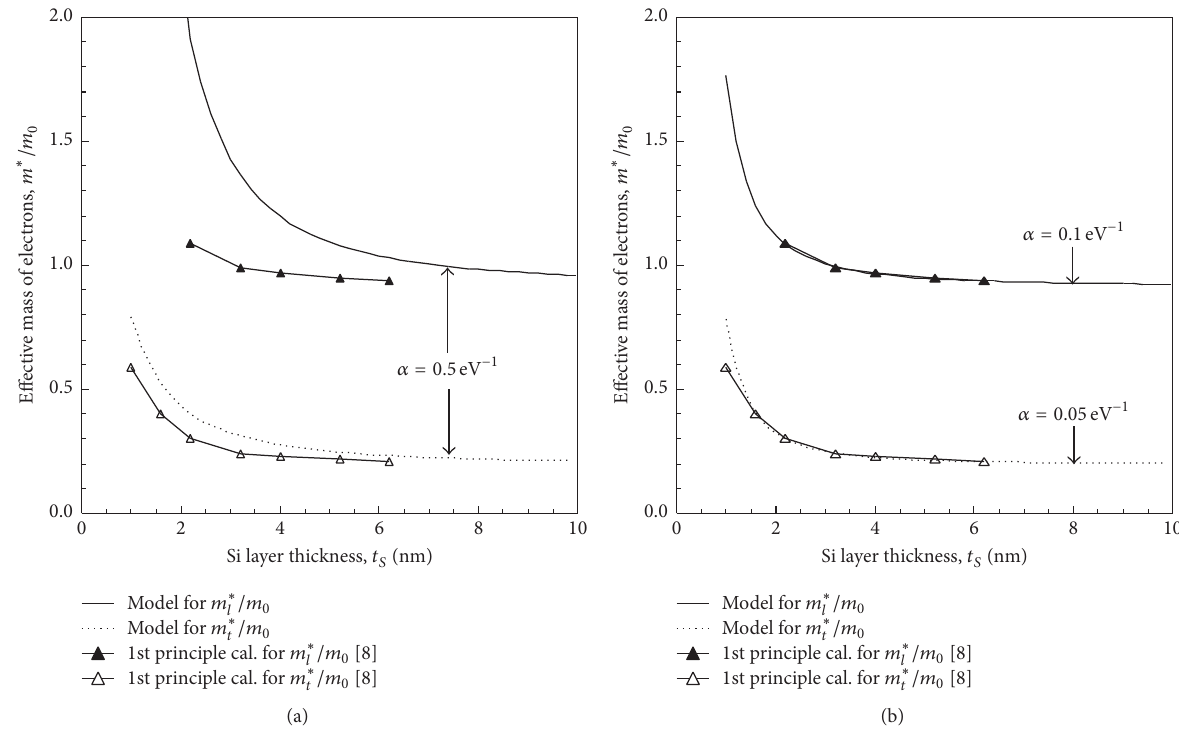
Figure 2: Calculated effective mass values of electrons occupying the 1st excited state as a function of semiconductor layer thickness [11]. (a) Effective mass dependence on Si layer thickness. It is assumed that 𝛼 = 0.5 eV −1 in order to calculate the nonparabolic band effect. (b) Effective mass dependence on Si layer thickness. It is assumed that 𝛼 = 0.1 eV −1 for 𝑚 𝑙 /𝑚 0 and 𝛼 = 0.05 eV −1 for 𝑚 𝑡 /𝑚 0 in calculating the nonparabolic band